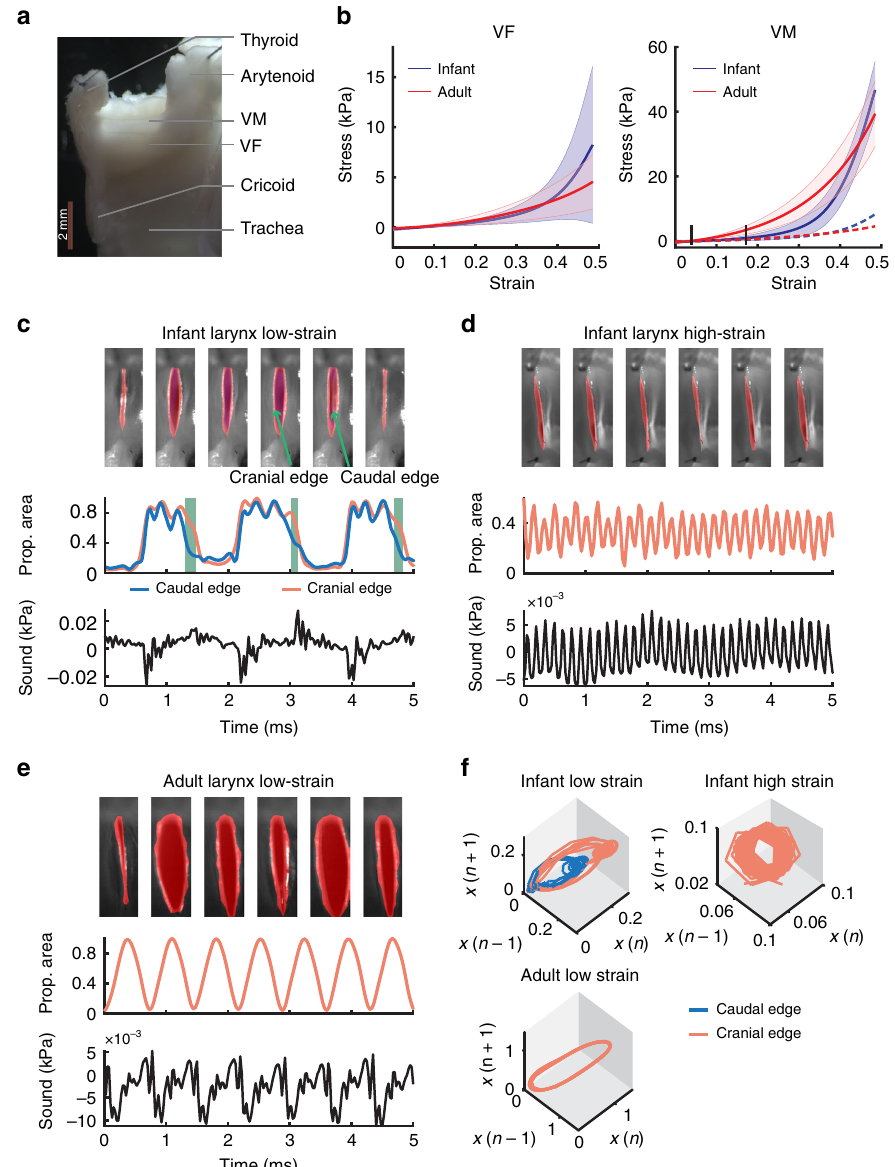
Fig. 3 Cry production is unique to infant larynx. a The sagittal section of an isolated adult marmoset larynx. The relative locations of vocal membrane (VM) and vocal fold (VF) are indicated. b Stress – strain responses for infant and adult VF and VM. The black line indicates diverging point between the VM and VF stress along the strain axis. The dashed curves are the VF stress – strain response. The shaded areas are standard deviation. c – e Glottal dynamics of c an infant larynx at low-strain region, d an infant larynx at high-strain region, and e an adult larynx at low-strain region. Top to bottom: snapshots of glottal opening and closure with the areas bounded by the cranial (in red; c – e ) and the caudal (in blue; only c ) edges, the proportional glottal areas (with respect to the maximum glottal area), and the distance-corrected sound pressure. In c , the green bars indicate that the caudal edge closed prior to the cranial edge. f The trajectories of the absolute glottal area (in mm 2 ) in the phase space for the instances corresponding to c – e